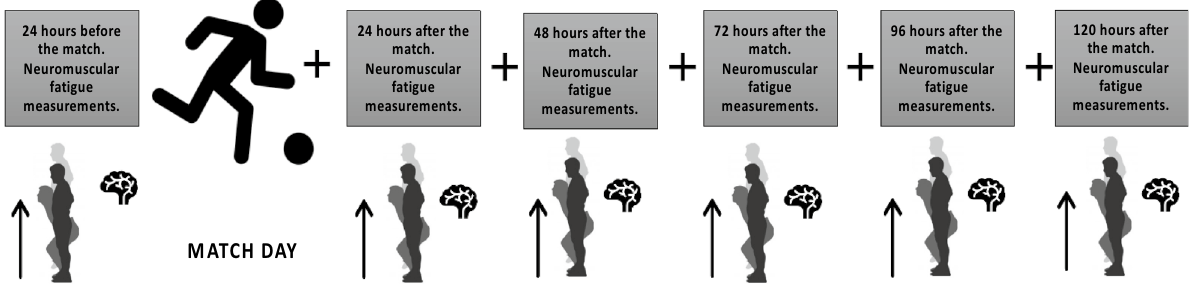
Figure 1. Plan structure of the experimental study